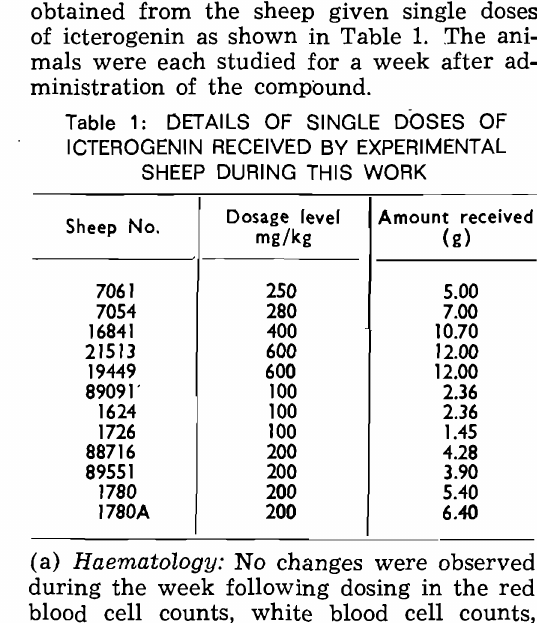
Table 1: DETAILS OF SINGLE DOSES OF ICTEROGENIN RECEIVED BY EXPERIMENTAL SHEEP DURING THIS WORK Sheep